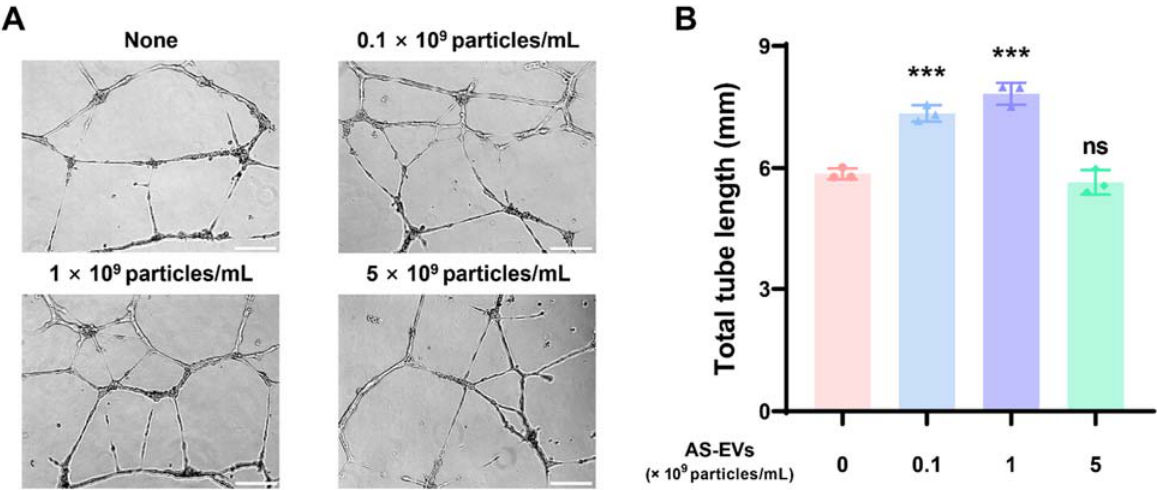
Figure 5. Effect of AS-EVs on the capillary-like tube formation of HUVECs. ( A ) Representative image of HUVEC tube formation. HUVECs plated on Matrigel-coated wells were treated with AS-EVs for 16 h in EGM-2 medium. Scale bar indicates 200 µ m. ( B ) Total tube length (mm) was measured using ImageJ software. Statistical significance was determined by comparison with the control group not treated with AS ‐ EVs (*** p < 0.005, n = 3).